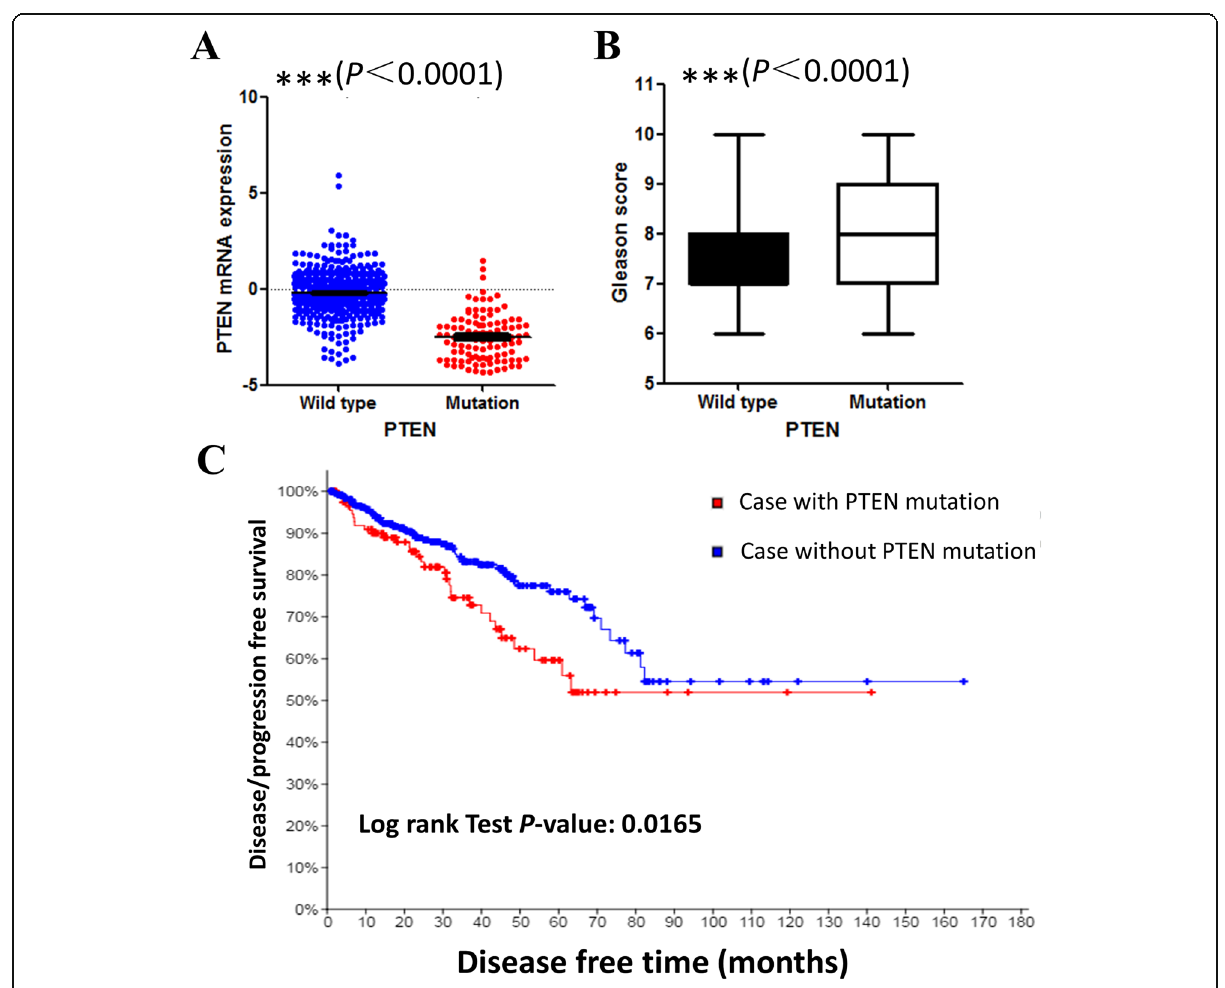
Fig. 3 Mutations of PTEN is associated with lower PTEN expression level, higher Gleason score and poorer prostate cancer prognosis. A. Correlation between PTEN mutation and PTEN mRNA expression. B. Correlation between PTEN mutation and Gleason score. C. Survival curves of PCa patients stratified by PTEN